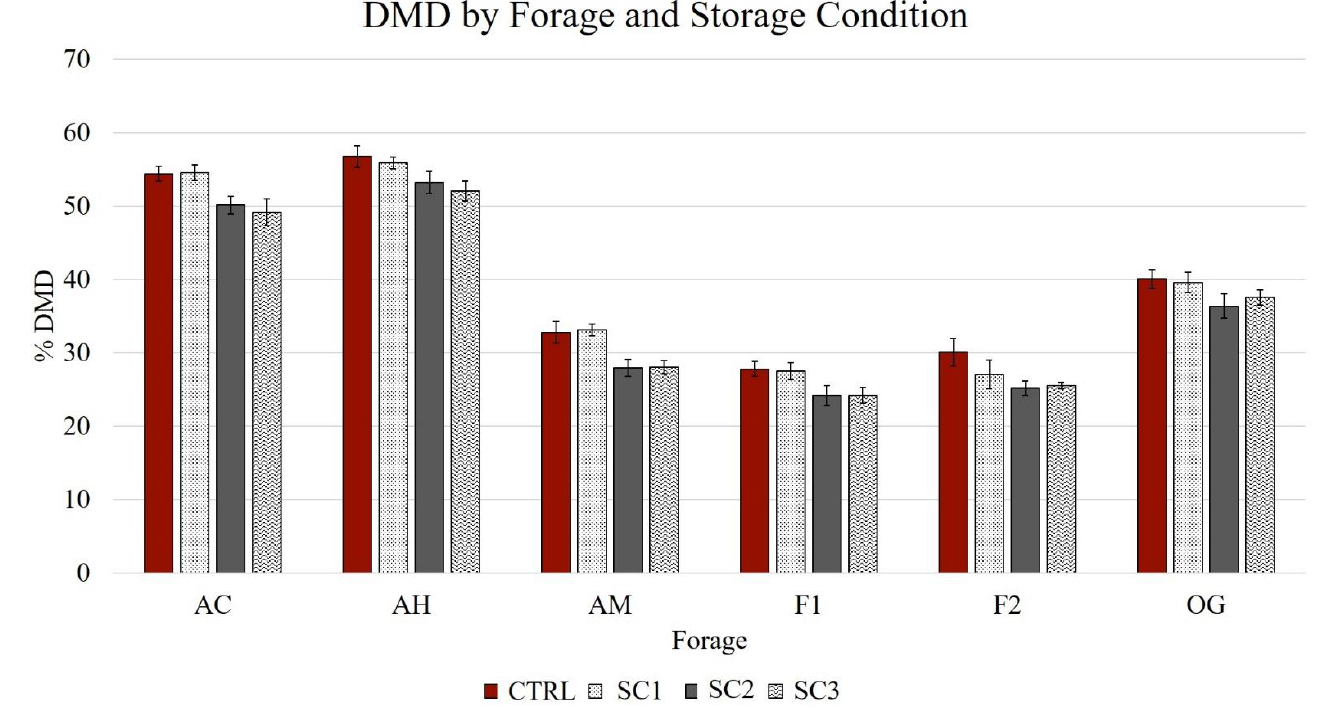
Figure 1. Equine dry matter digestibility of forage by microbial inoculum storage condition, grouped by forage type AC, alfalfa cubes; AH, alfalfa hay; AM, alfalfa mix; F1, fescue hay 1; F2, fescue hay 2; OG, orchardgrass hay.